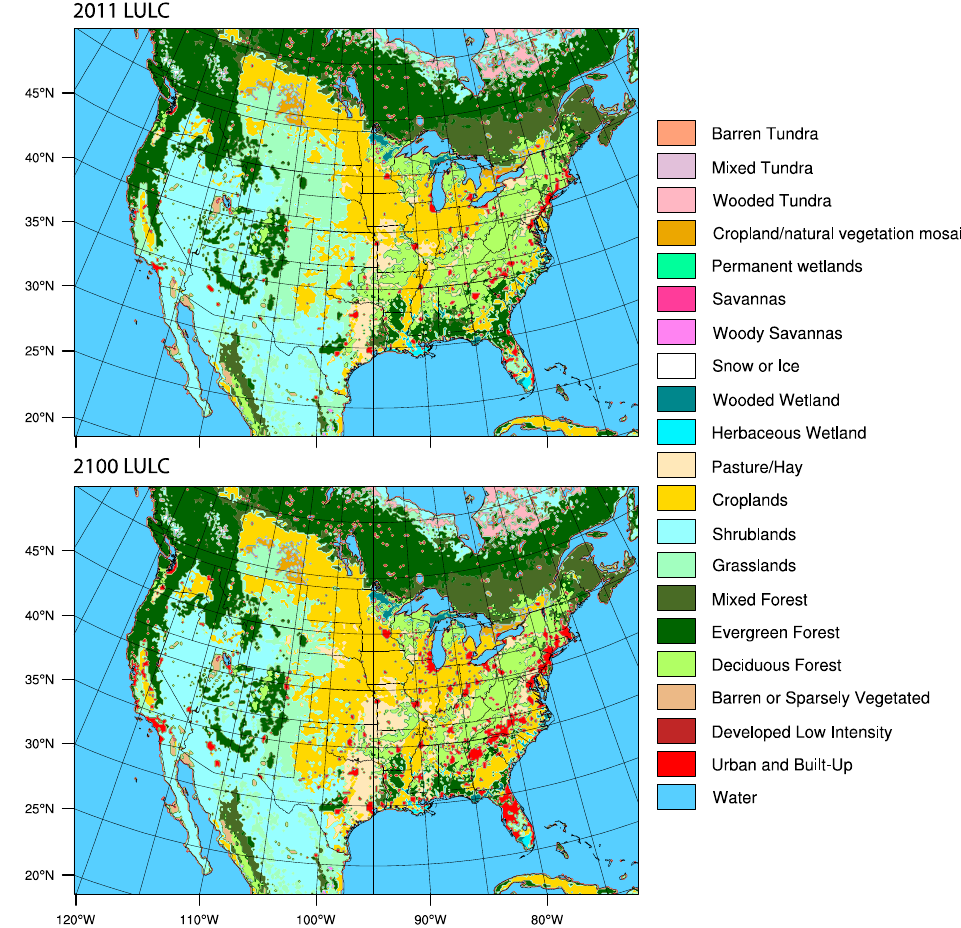
Figure 1. Land-use/land-cover (LULC) for 2011 and 2100 and the modeling